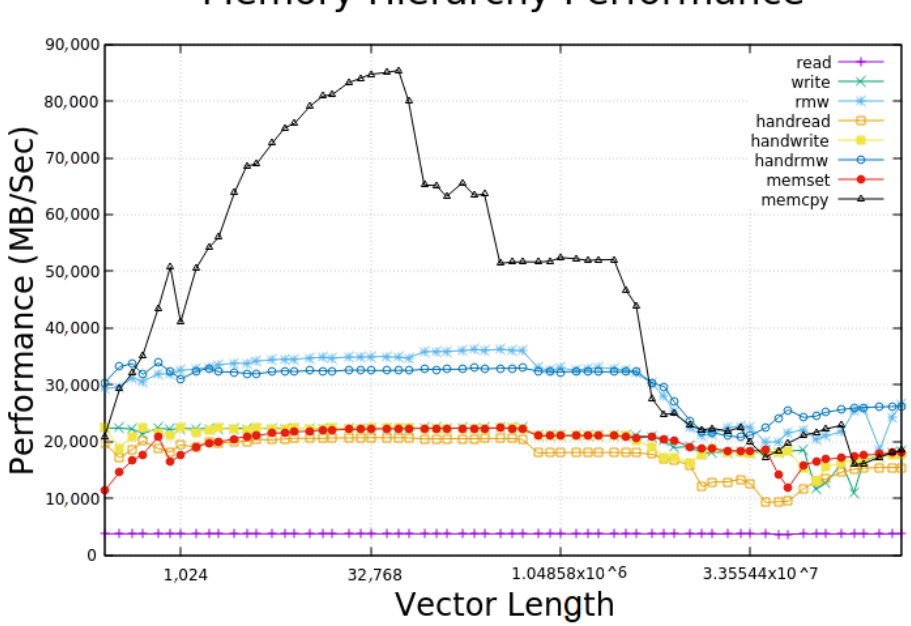
Figure 16. Cache Bench results of Quinde